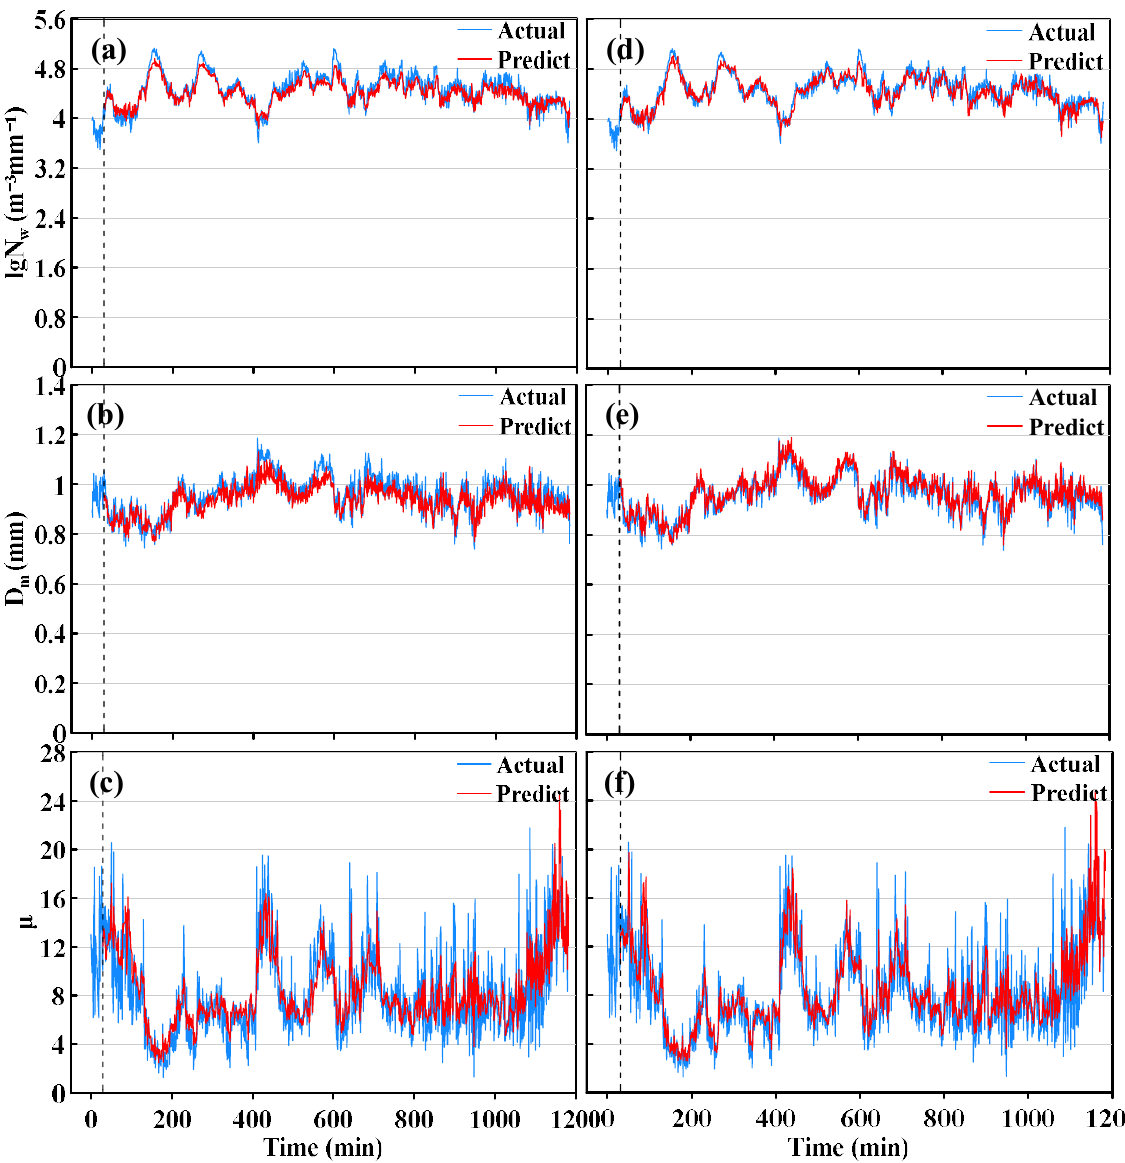
Figure 9. The curve of the 12-min prediction for the stratiform cloud precipitation case, in which the horizontal axes are rainfall duration time (min); vertical axes are ( a , d ) lgN w , ( b , e ) D m (mm), and ( c , f ) μ; the red and blue curves represent the predicted and actual values; and the vertical dotted line is at the minute of T step + M pred . Modeling with MLF is shown on the left ( a – c ), and with SLF on the right ( d – f ).